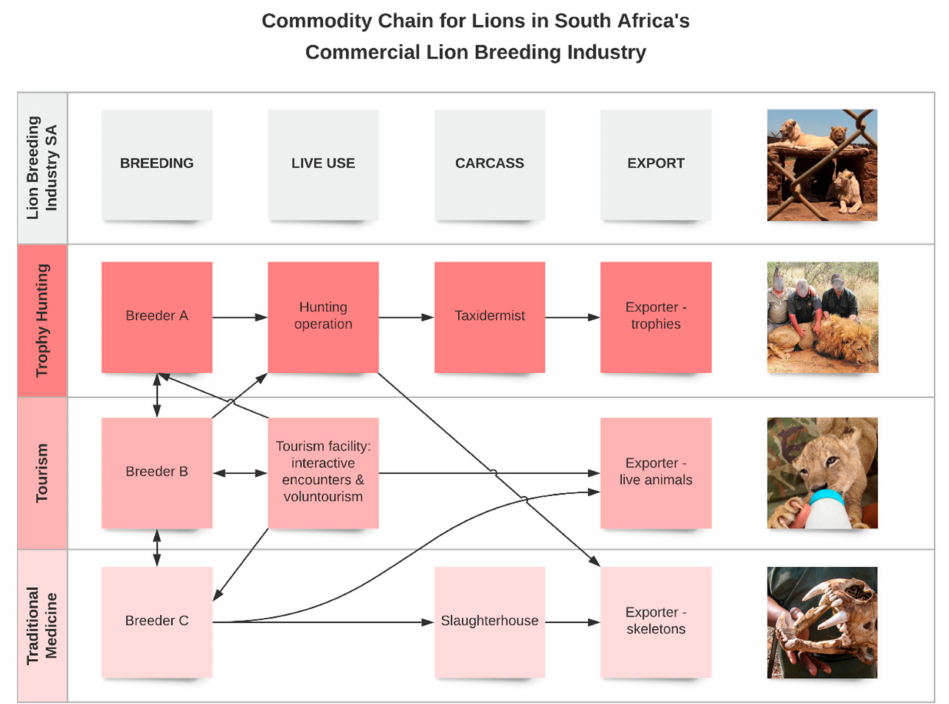
Figure 1. Commodity chain for lions in South Africa’s commercial captive breeding industry. The three recognised